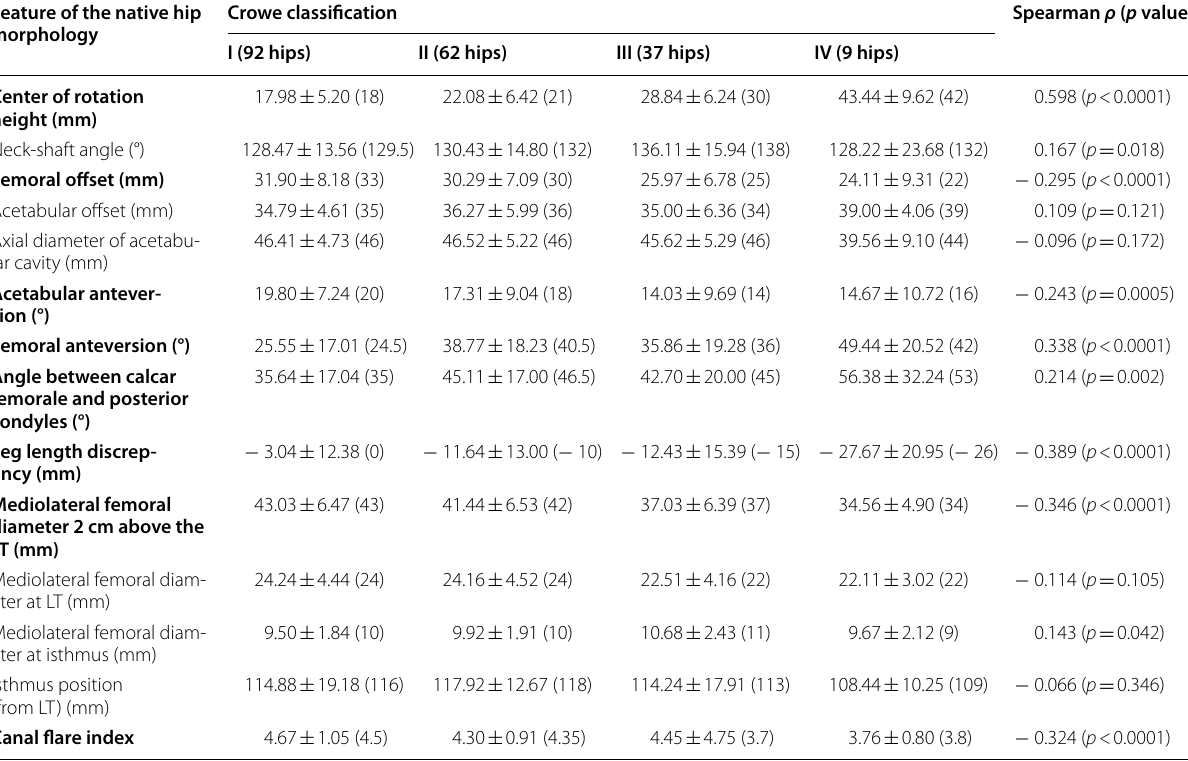
Table 1 The native hip morphology was described using several CT-based measurements (mean parentheses): the features that are correlated with the Crowe classification are shown in bold ( LT lesser